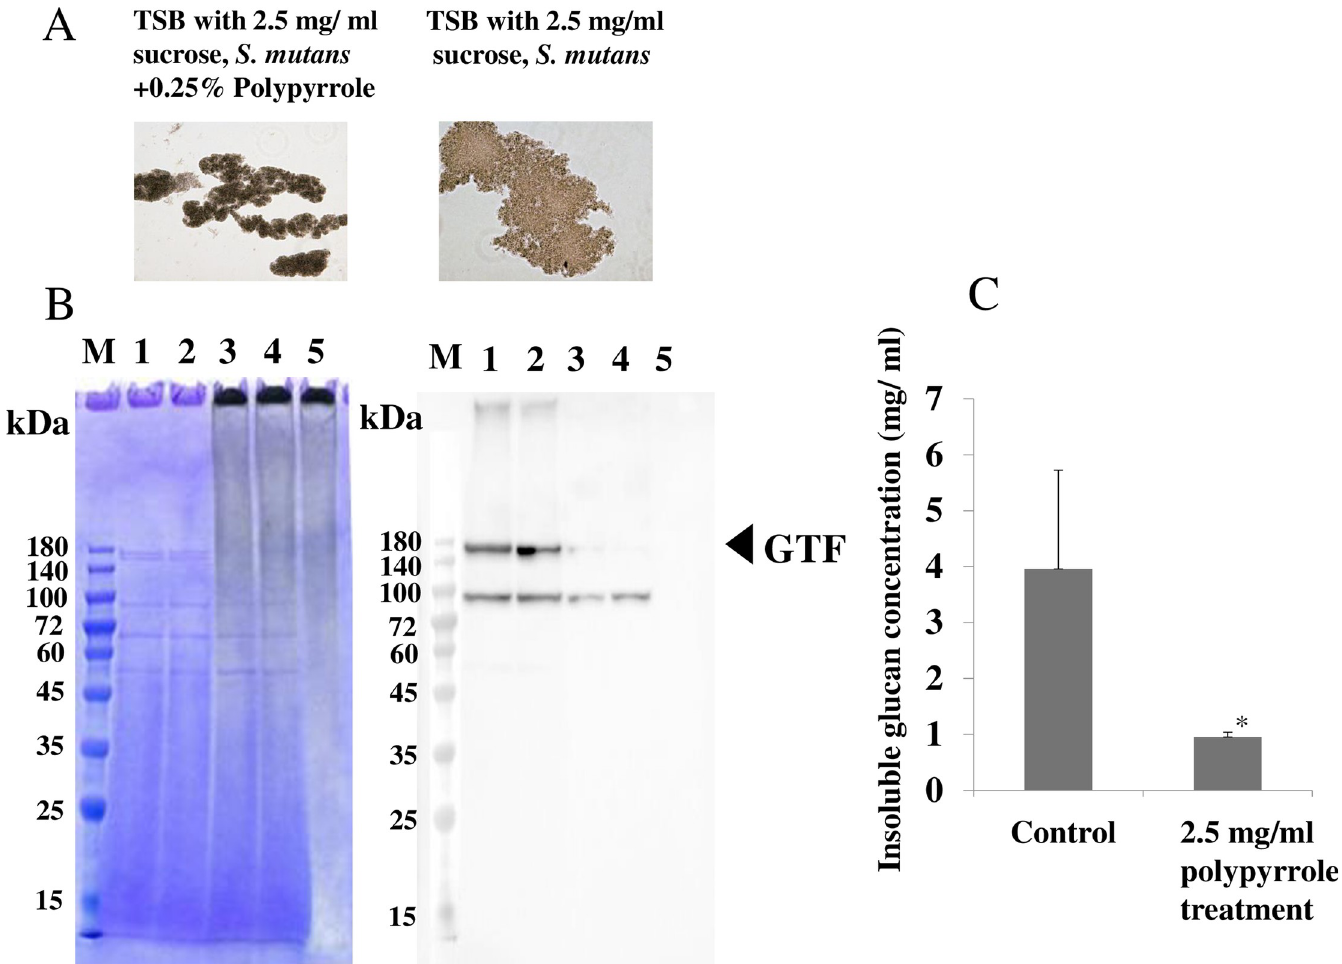
Fig 2. The effects of polypyrrole on the aggregation and production of insoluble glucan in S . mutans . The effects of polypyrrole on the aggregation and production of insoluble glucan by S . mutans were observed after incubation for 16 h in TSB supplemented with 0.25% sucrose. A: Aggregations of S . mutans UA159 were observed at a high concentration of polypyrrole (2.5 mg/ml). B: Effects of polypyrrole (2.5 mg/ml) on the proteins produced by S . mutans UA159 in culture supernatant were analyzed by SDS-PAGE and Coomassie Brilliant Blue staining, and western blotting. M: Molecular size marker, 1: culture supernatant experiment 1, 2: culture supernatant experiment 2, 3: culture supernatant experiment 1 + 2.5 mg/ ml polypyrrole, 4: culture supernatant experiment 2 + 2.5 mg/ ml polypyrrole, 5: 2.5 mg/ ml polypyrrole/PBS. C: The production of insoluble glucan by S . mutans UA159 was quantitatively analyzed at a high concentration of polypyrrole (2.5 mg/ml). The data indicated the mean ± SD of triplicate experiments. The independent experiments were performed 3 times, with similar results obtained in each. The asterisks indicated a statistically significant difference between 2 groups (Student’s t -test; p < 0.05, vs no treatment control).